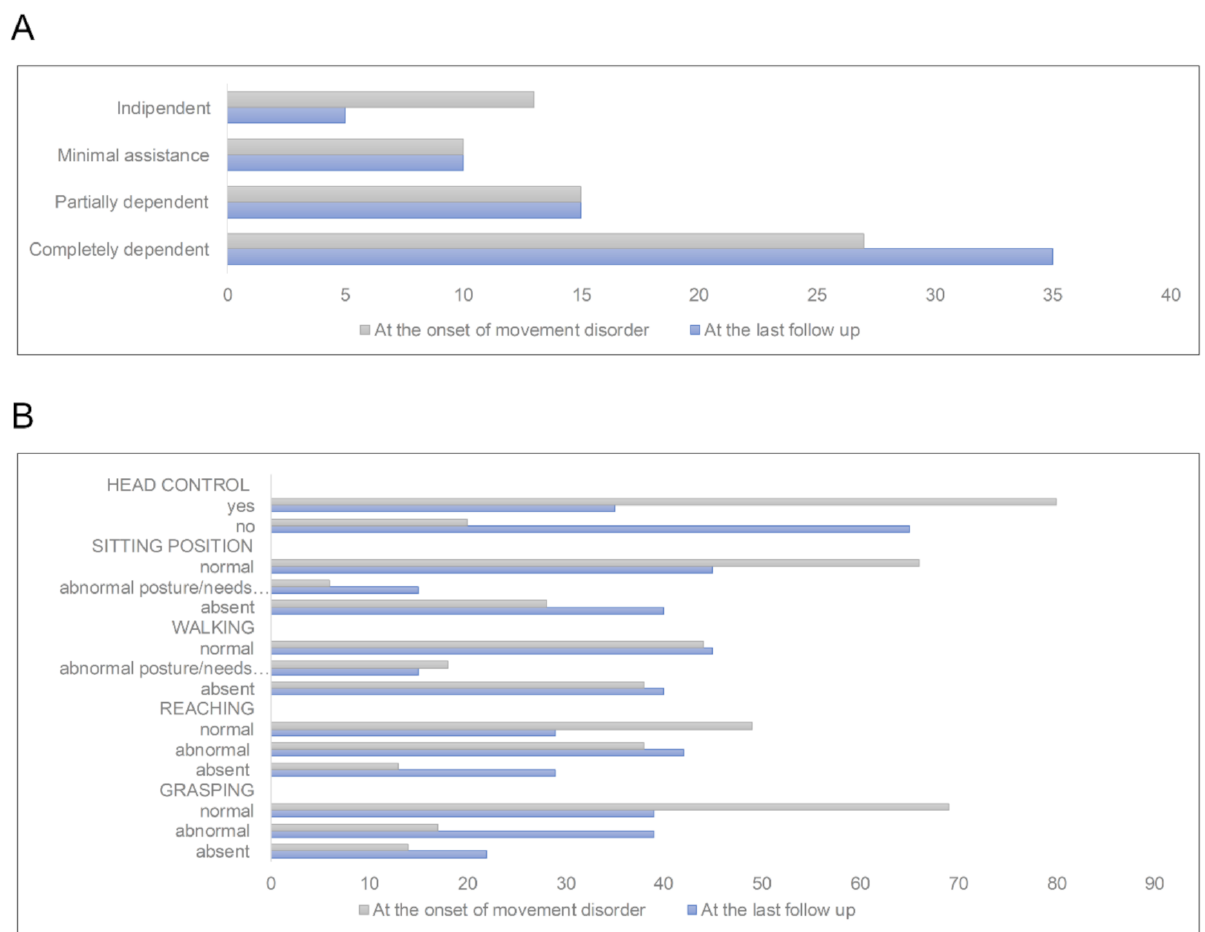
Figure 2. Level of dependence in activities of daily living and motor functions in mitochondrial patients with movement disorder. ( A ) Level of dependence in activities of daily living, assessed both at the onset of movement disorder and at the last follow-up. Data were available for 65 patients only. ( B ) Motor function assessed both at the onset of movement disorder and at the last follow-up. Data on onset motor skills were available for 64 patients; data on last follow-up skills were available for 58 patients. Values are reported as number of